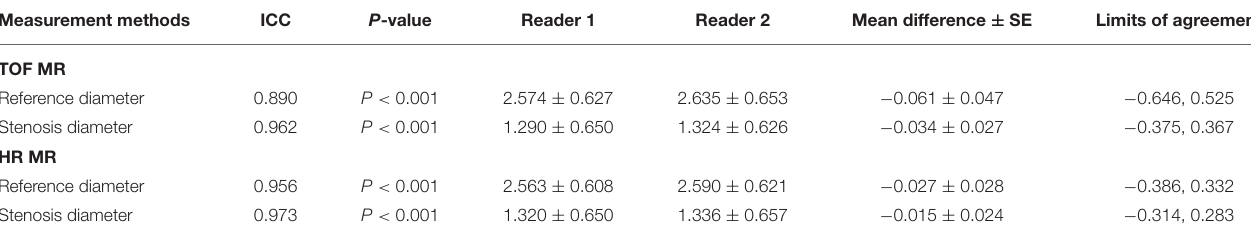
TABLE 2 | Inter-reader agreement of arteries without total occlusion on time-of-flight magnetic resonance (TOF-MR) and HR-MR images. Measurement methods